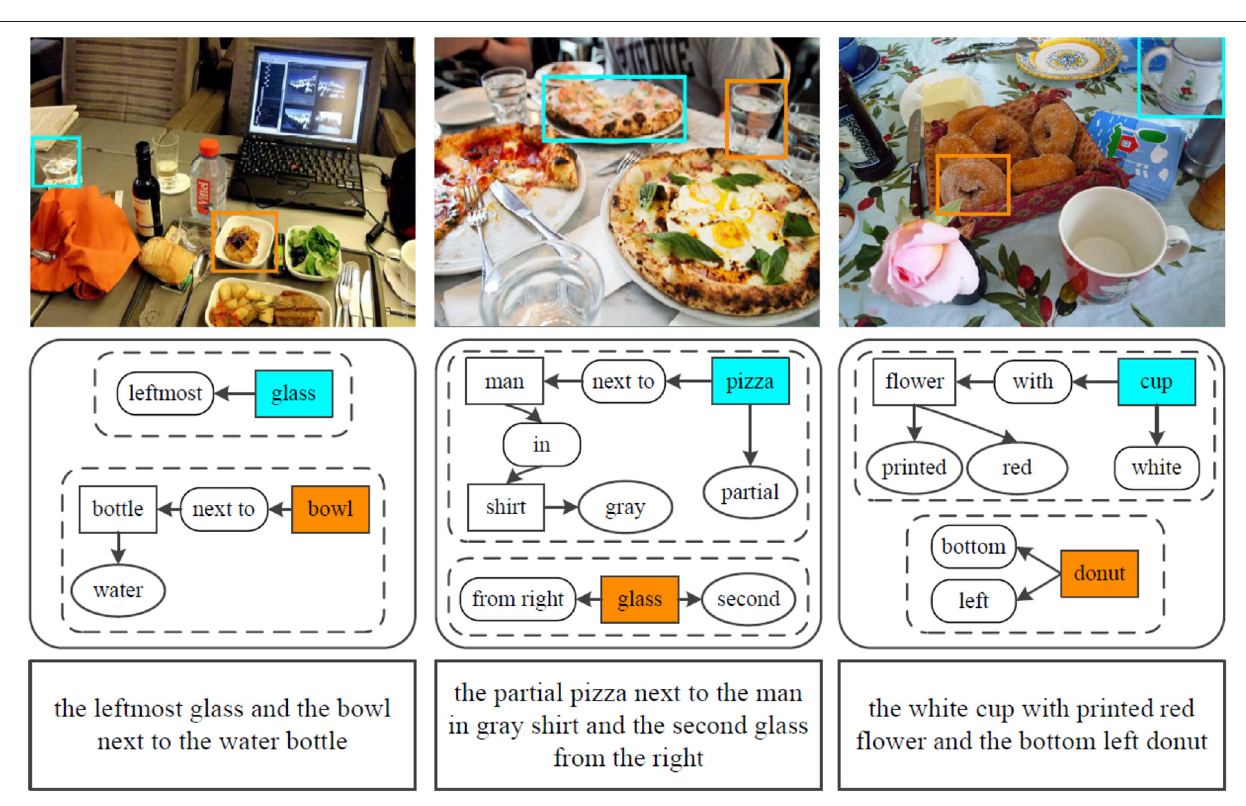
working scenarios. Instead of discarding spatial location words in expressions provided by RefCOCO +